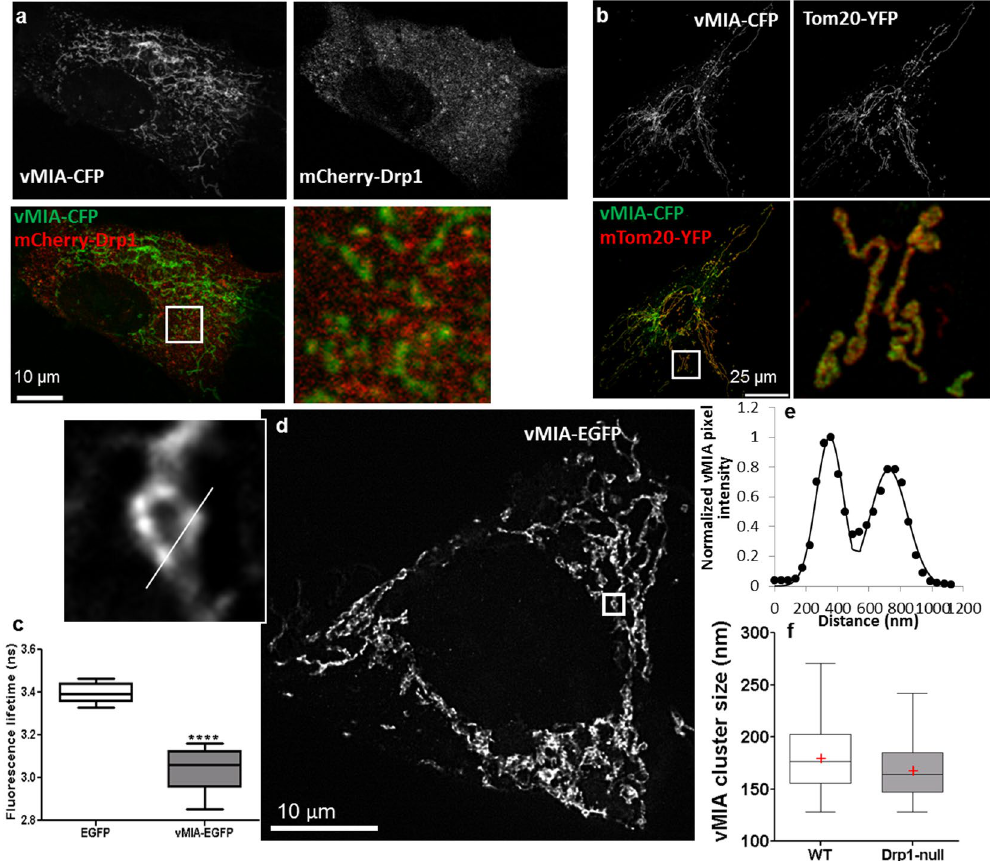
Figure 6. Role of Drp1 on vMIA trafficking and clustering on the mitochondria. ( a ) HFFs were lipofected with vectors expressing vMIA-CFP (pseudocolored green) and mCherry-Drp1 (red) 57 . Cells were imaged by confocal microscopy and single slice of the deconvolved images is shown as monochrome and pseudocolored images as above. ( b ) Confocal image of a Drp1-null MEF transiently expressing vMIA-CFP (pseudocolored green) and Tom20-YFP (pseudocolored red). Monochrome images show the individual channels and the merged image demonstrates vMIA colocalization with Tom20-YFP. A zoom of the boxed region of interest is shown. ( c ) The fluorescence lifetime comparison of cytosolic EGFP ( τ = 3.40 ± 0.013 ns, n = 120 regions from 12 cells) and vMIA-EGFP ( τ = 3.04 ± 0.026 ns, n = 130 regions from 13 cells) in Drp1-null MEFs. ( d ) A single plane from an MSIM z-stack images showing clustered distribution of vMIA-EGFP on the OMM of a transfected Drp1-null MEF. A zoom of a single mitochondrion shows vMIA clustering. ( e ) Normalized pixel intensities of a line shown along the mitochondrion in inset of panel d. ( f ) Box plot showing the distribution of vMIA clusters (n = 40 cells) in WT MEFs and Drp1-null MEFs. **** Indicates p <